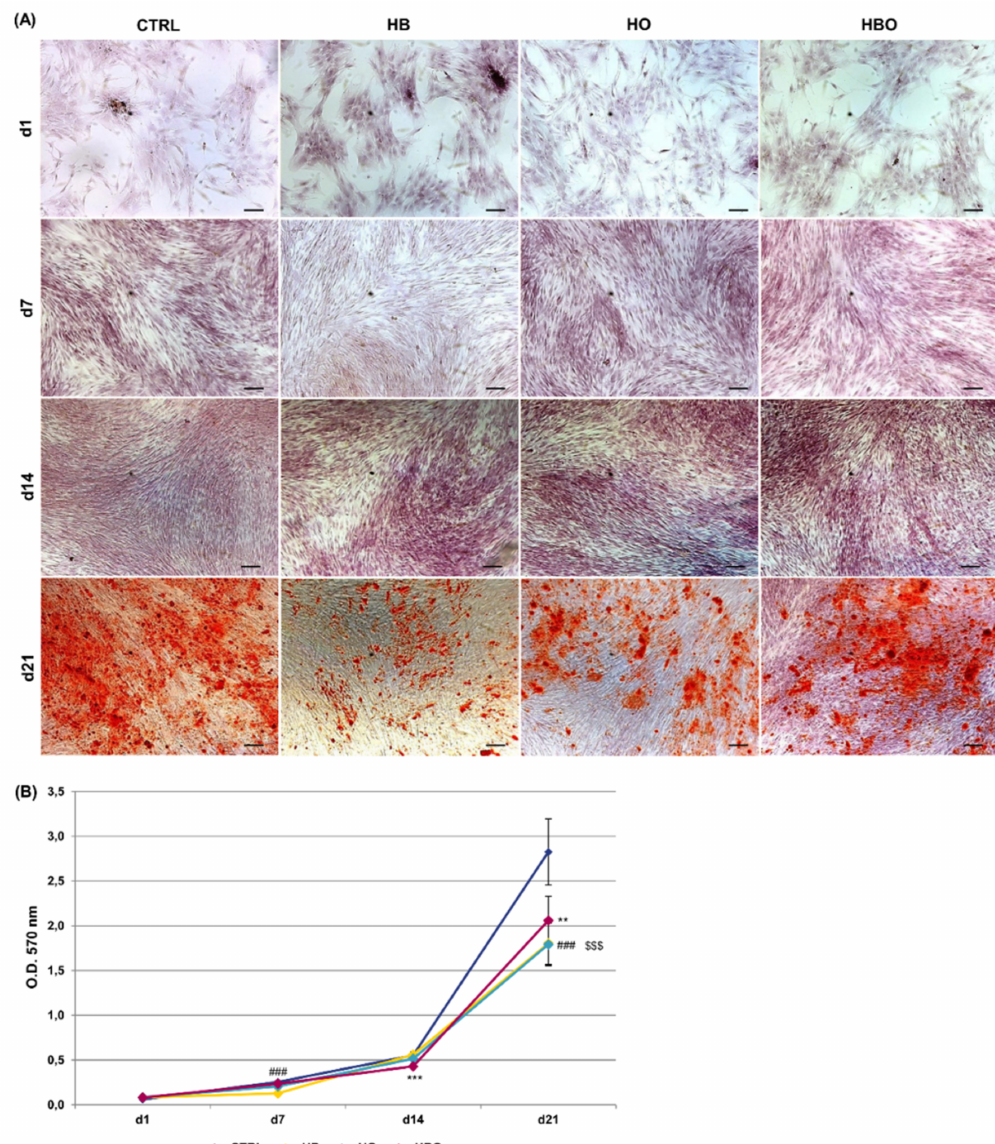
Figure 3. Matrix mineralization in hADSCs after HBO treatment. ( A ) Alizarin Red S (ARS) staining and ( B ) quantification of calcium deposits in hADSCs after d1, d7, d14, and d21 of culture in ODM and HBO, HB, or HO treatment. Scale bars 100 µ m. Data are shown as mean ± SD. ** p < 0.01 and *** p < 0.001 indicate statistically significant di ff erence between the HBO-treated cells and the control group, respectively. ### and $$$ p < 0.001 indicate statistically significant di ff erence between HB- and HO-treated cells and control,